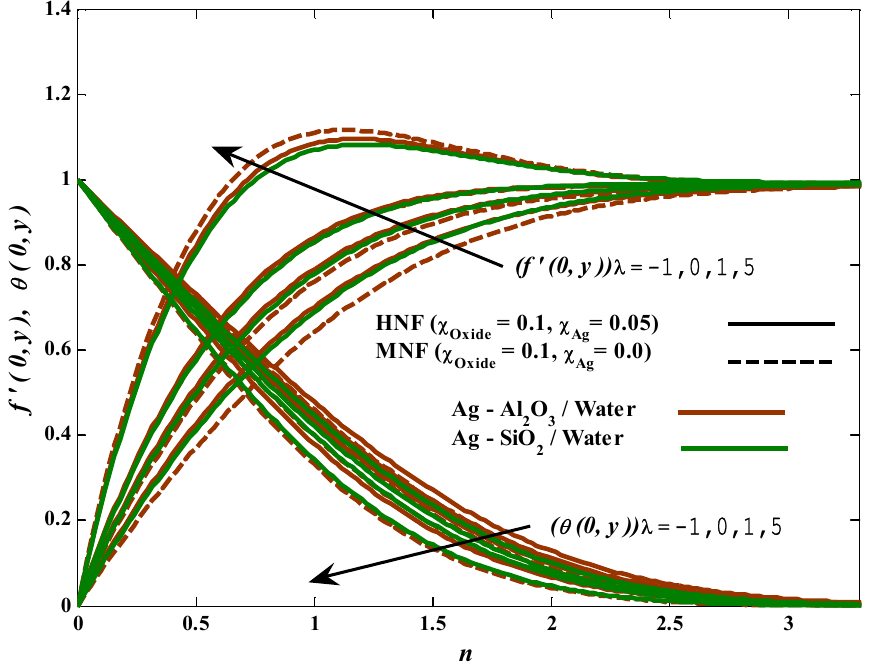
Figure 13. Illustration of λ versus temperature and velocity at fixed values of We = 0.2, R = 0.1, & M =